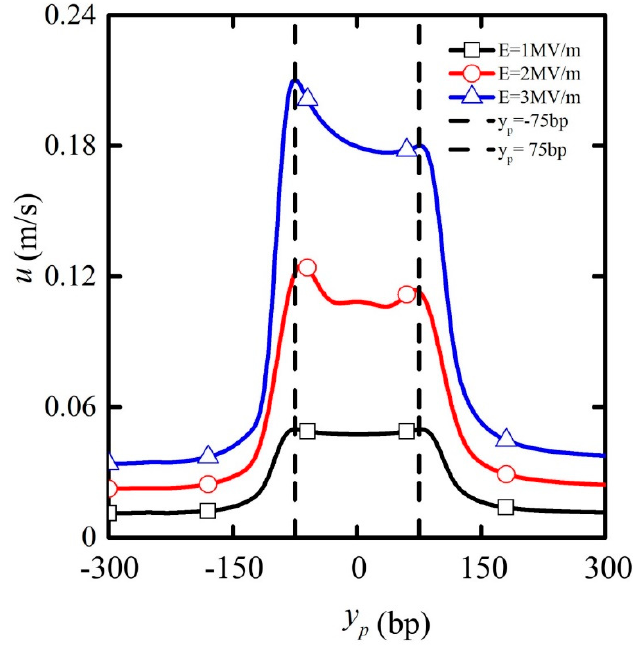
Figure 3. The particle translation velocity depending on particle position under the applied electric field strength of E = 1 MV / m (black line with squares), E = 2 MV / m (red line with circles), and E = 3 MV / m (blue line with triangles) for particle length L p = 200 bp. The vertical dotted lines indicate the locations y p = − 75 and y p = 75 bp.